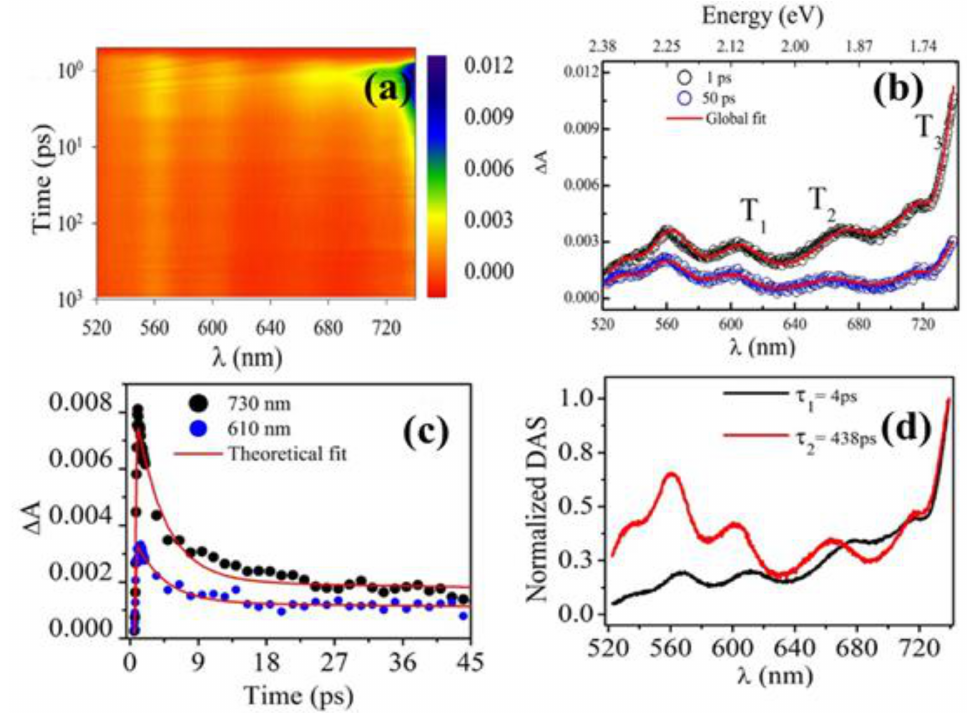
Figure 10. ( a ) 2D contour plot of TA spectra of GeSe 2 thin film for probe delays in ps time domain. ( b ) TA spectra at different probe delays at ps time. ( c ) Temporal evolution of TA at 730 and 610 nm along with theoretical fit (red line). ( d ) Normalized decay associated spectra (DAS) in ps time delays. All Figures are reprinted with permission from [15] Copyright 2014, Springer